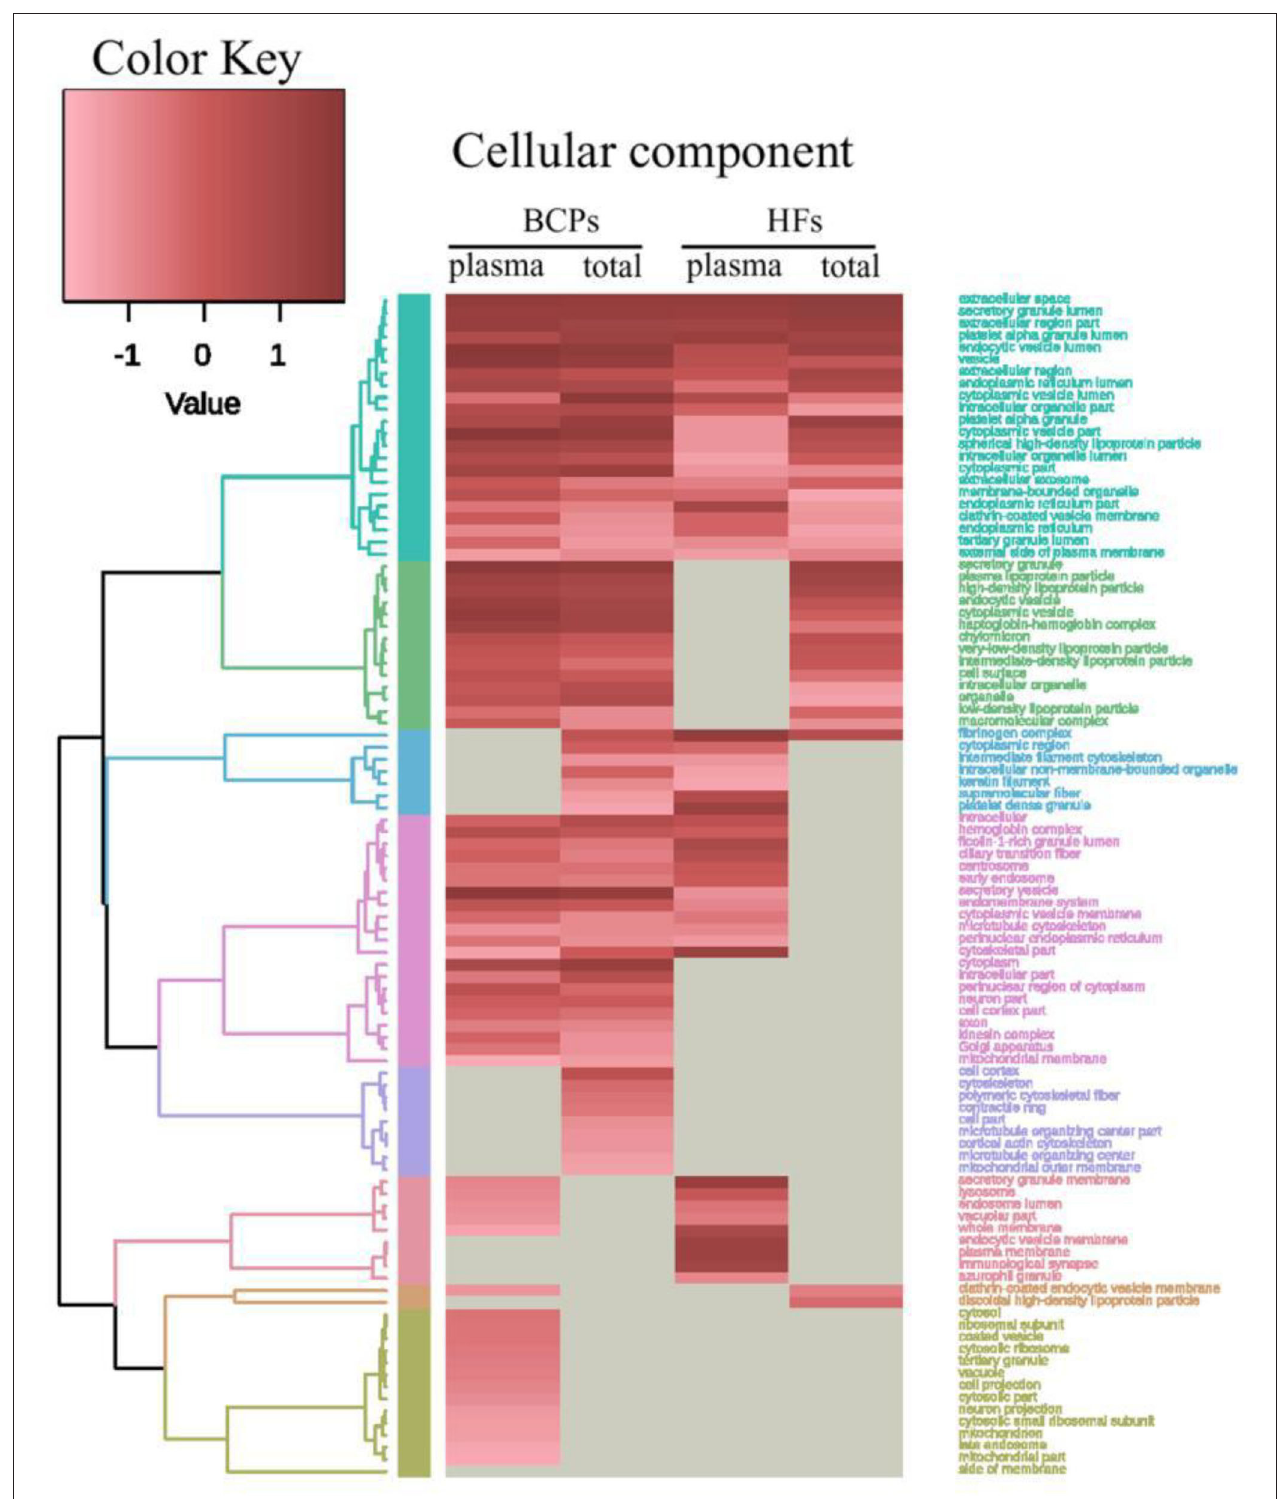
FIGURE 5 | Heat map and dendrogram of the results of GO functional enrichment analysis of exosomal proteins from BCPs and HFs by Cellular Components obtained via STRING (https://string-db.org/) and visualized using R (https://www.r-project.org/).